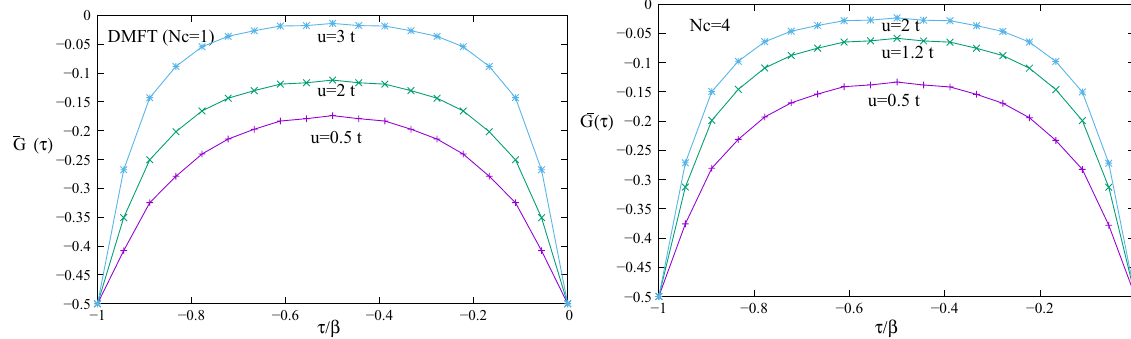
Figure 4. Shows calculated interacting graphene imaginary time average Green function ¯ G ↑↑ ( I , I